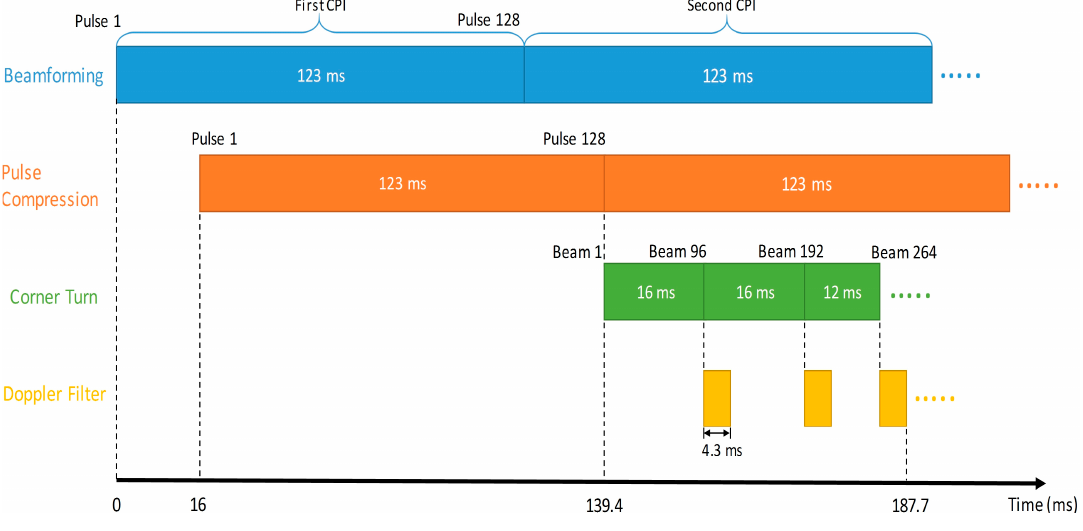
Figure 14. Real-time system timeline for the example backend system.